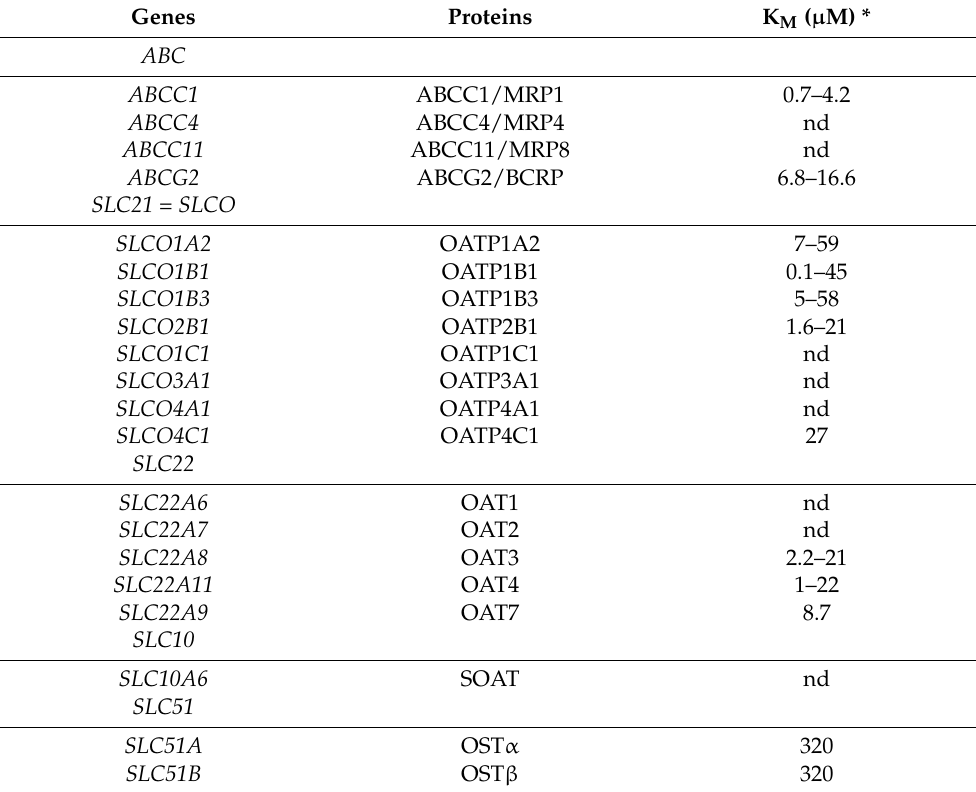
Table 1. E1-S uptake and efflux transporters from the ABC and SLC gene